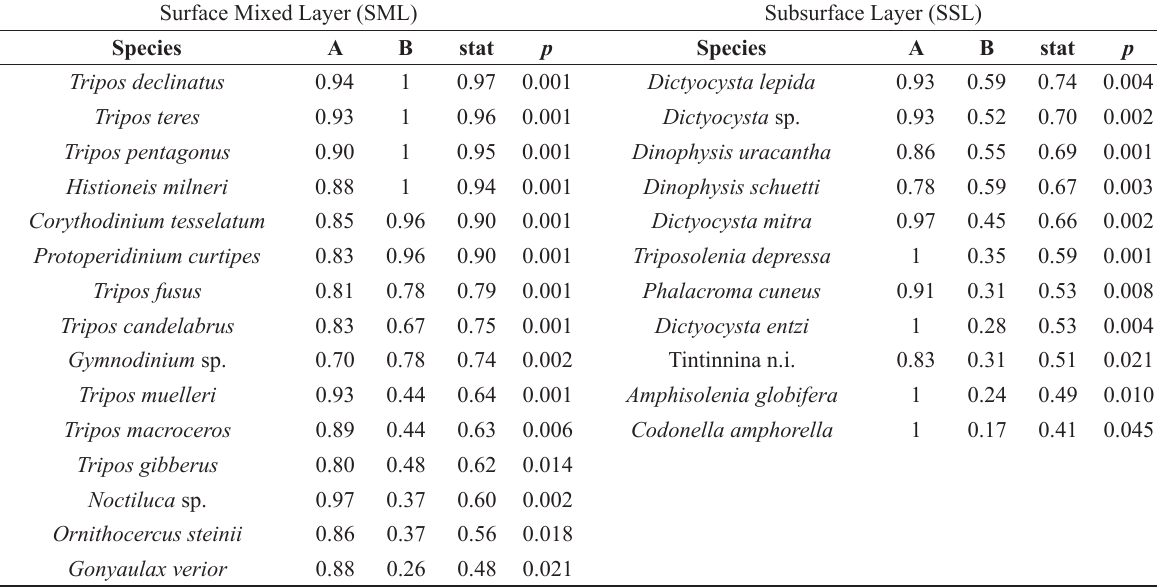
Indicator species determined by the Indicator Value